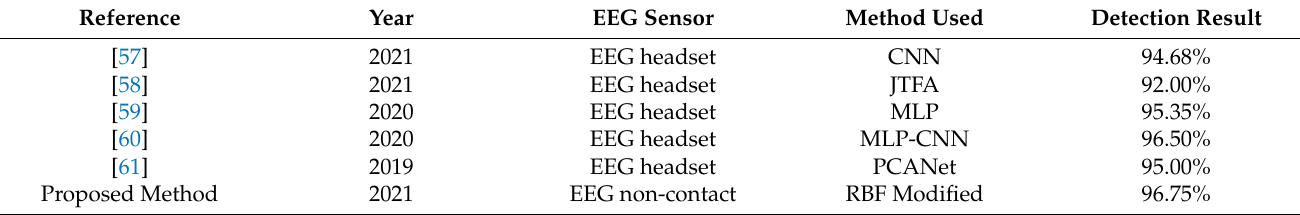
Table 2. Comparison of methods used in the automatic detection of drowsiness and cognitive